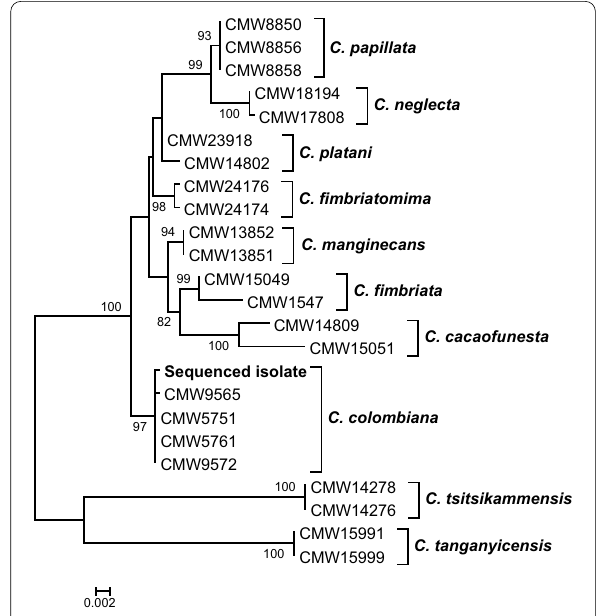
Fig. 2 Phylogenetic tree generated from maximum likelihood analysis of the combined dataset ITS, βT and EF1‑α gene regions. The sequences were extracted from the genome assembly of the sequenced isolate (bold type) and analysed together with reference sequences from Van Wyk et al. (2010). The C. colombiana (CMW5751) sequenced in this study resided in the same clade with original C. colombiana isolates described by Van Wyk et al.